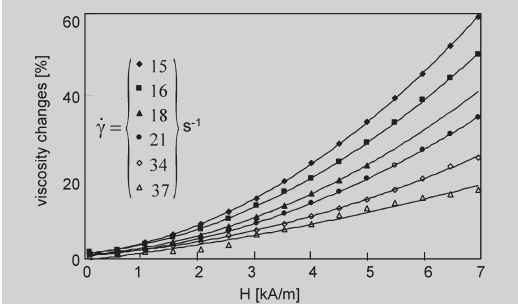
Figure 5 (left): Different field geometries used in rheometers for mag- netic fields. Left side: The Couette arrangement with magnetic pole shoes (top view). Right side: cone plate arrangement with Couette part and field parallel to the symmetry axis. The Couette part is necessary to avoid dewetting of the cone due to spike formation in the field. Figure 6: Relative change of viscosity in a commercial ferrofluid obtained with a cone plate rheometer for various shear